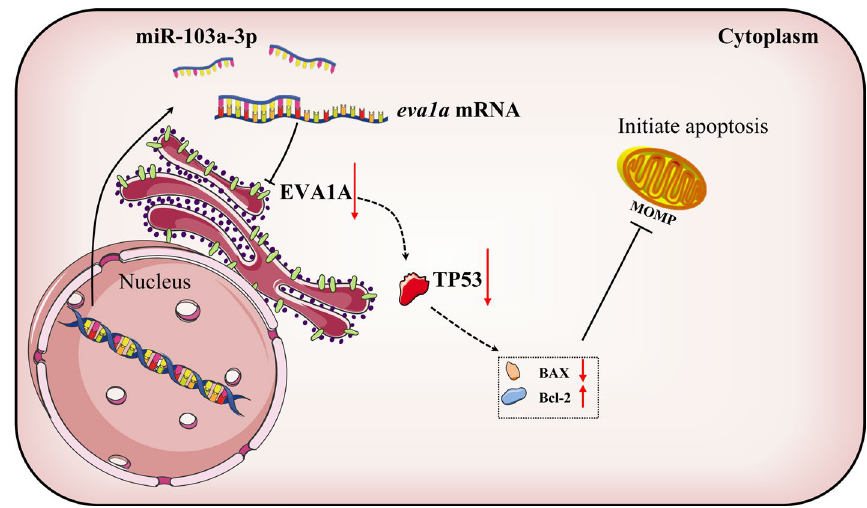
Fig. 9 Schematic representation of a model depicting the underlying molecular mechanisms of the miR-103a-3p /EVA1A/TP53 regulatory axis in HCC. The increased expression of miR-103a-3p of human hepatocyte targets EVA1A mRNA and inhibits its expression, resulting in a decline of TP53 and BAX (pro-apoptotic protein), an increase of BCL-2(anti-apoptotic protein), and repression of MOMP, thereby inhibiting cell apoptosis and causing the tumor suppressor effect of EVA1A to be weakened. MOMP, mitochondrial outer membrane